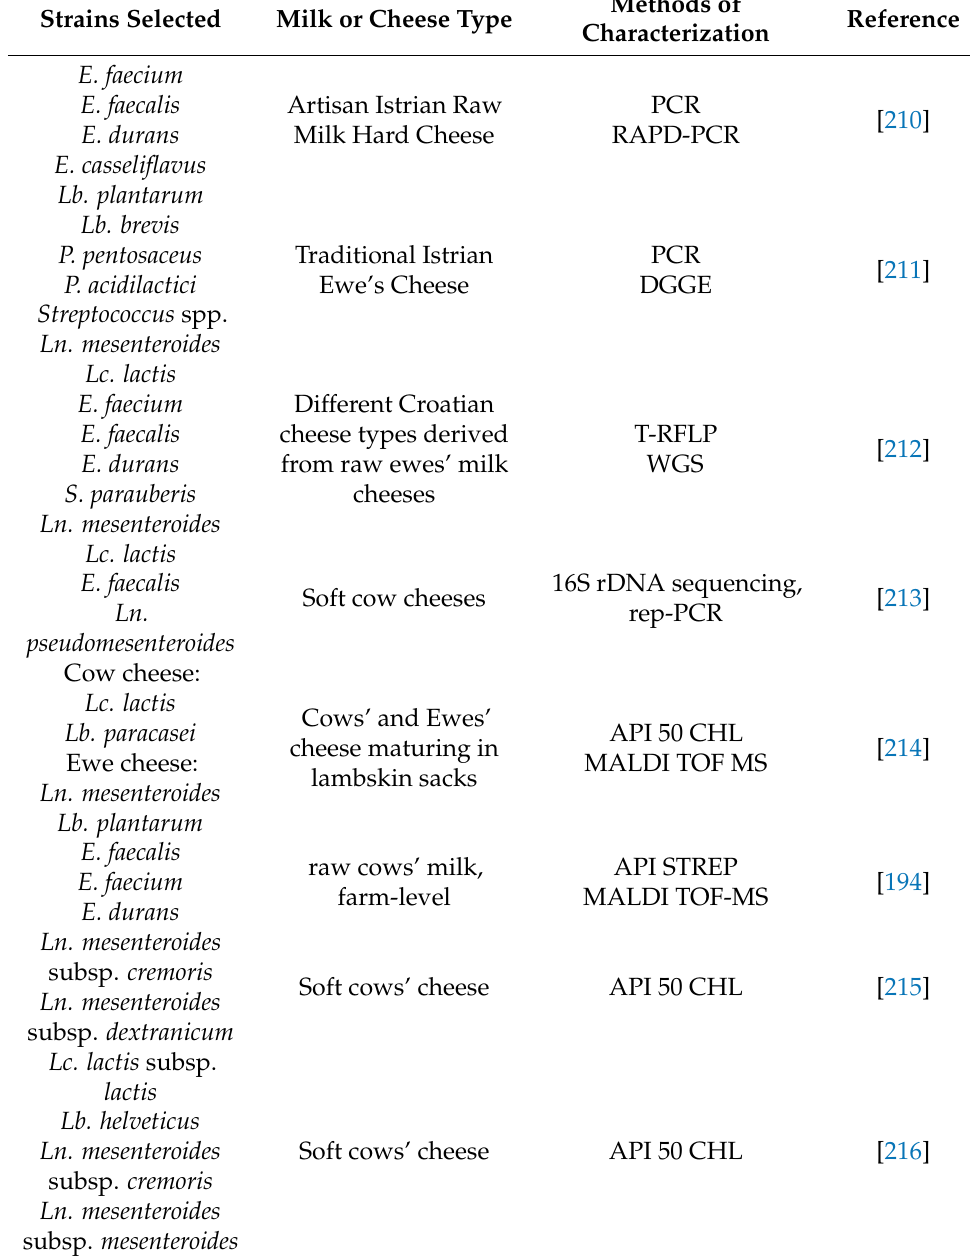
Table 5. Results of determination of indigenous microbiota lactic acid bacteria (LAB) of different types of milk and cheese in